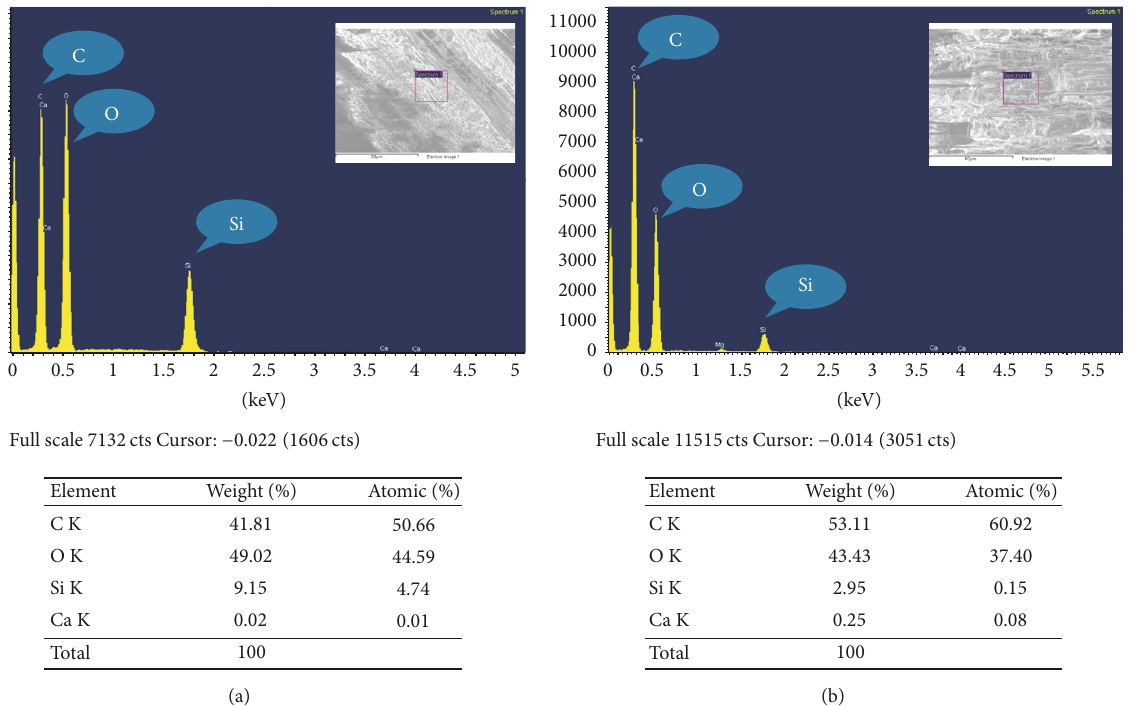
Figure 5: EDX profiles and elemental compositions of (a) untreated RS and (b) aRS.